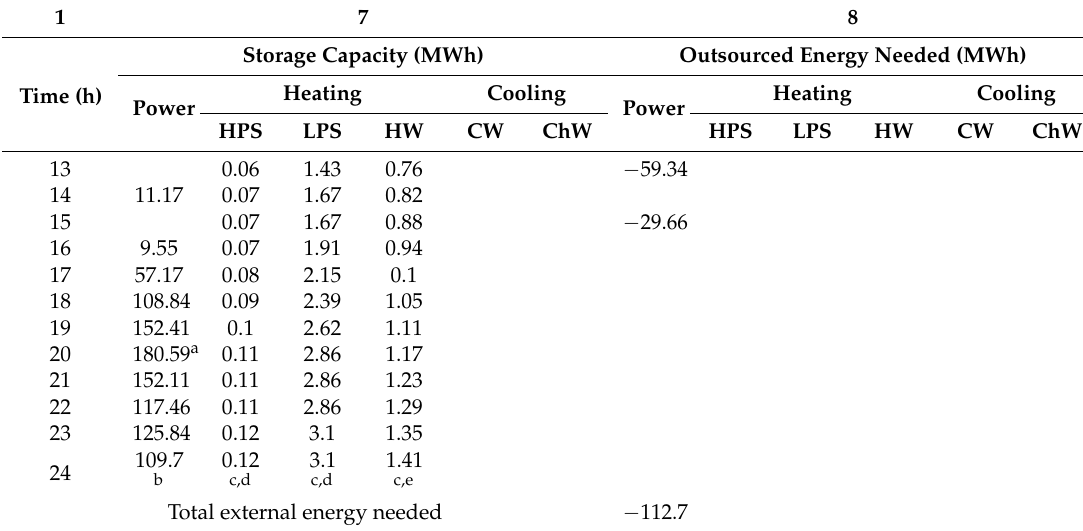
Table A18. TriGenSCT after iteration from time 13 to 24